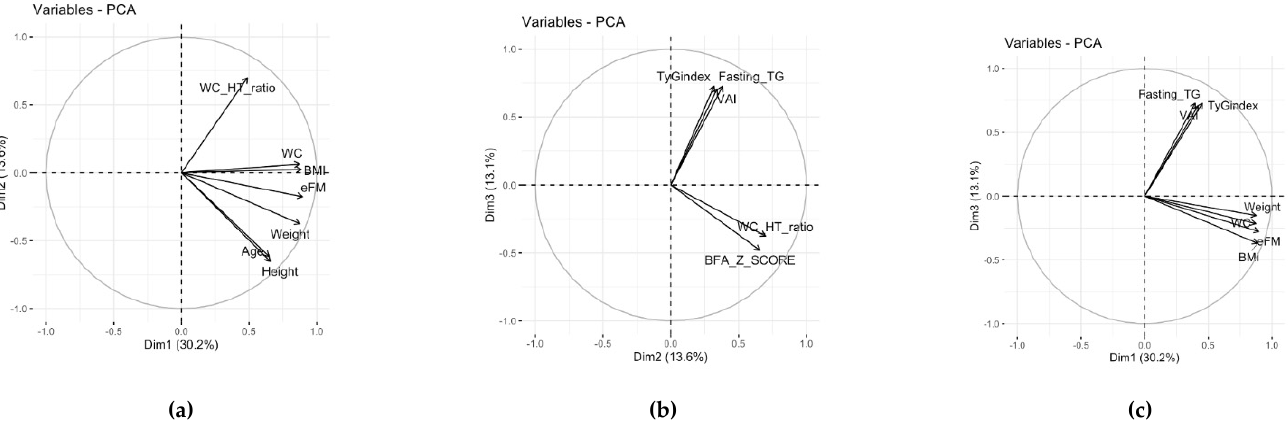
Figure 1. In these panels, the correlations are represented as vectors of each variable projected in the new subspaces defined by the principal components derived by the multivariate analysis (PCA). For clarity reasons, only the variables that contributed the most to the definition of the PCs and are represented more in the plane are displayed ( a – c ). The more the variables are correlated, the more they are projected on the same line. If they are positively correlated, they show the same direction; otherwise, they go in the opposite direction. On the other hand, if the variables are uncorrelated, they tend to project perpendicularly to form an angle of 90°.